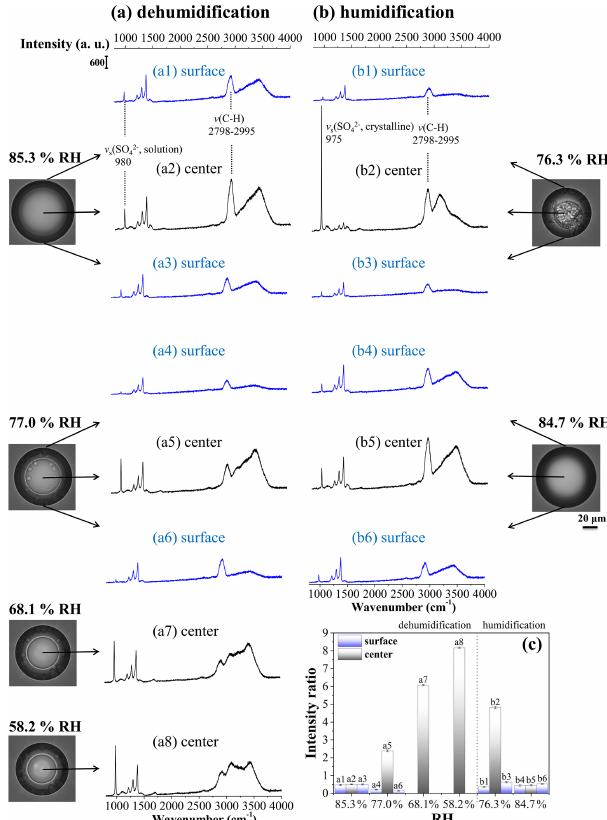
Figure 3. Raman spectra acquired on the surface (blue) and at the center (black) of the OIR = 1 : 1 particle during dehumidifi- cation (a) and humidification (b) , as well as intensity ratios of ν s (SO 2 − ) band to ν (C–H) band among all the spectra (c) . Note that 4 the value of b2 in (c) represents the intensity ratio of the stretch- ing vibration bands of crystalline SO 2 − to C–H. The corresponding 4 microscopic images are shown near the